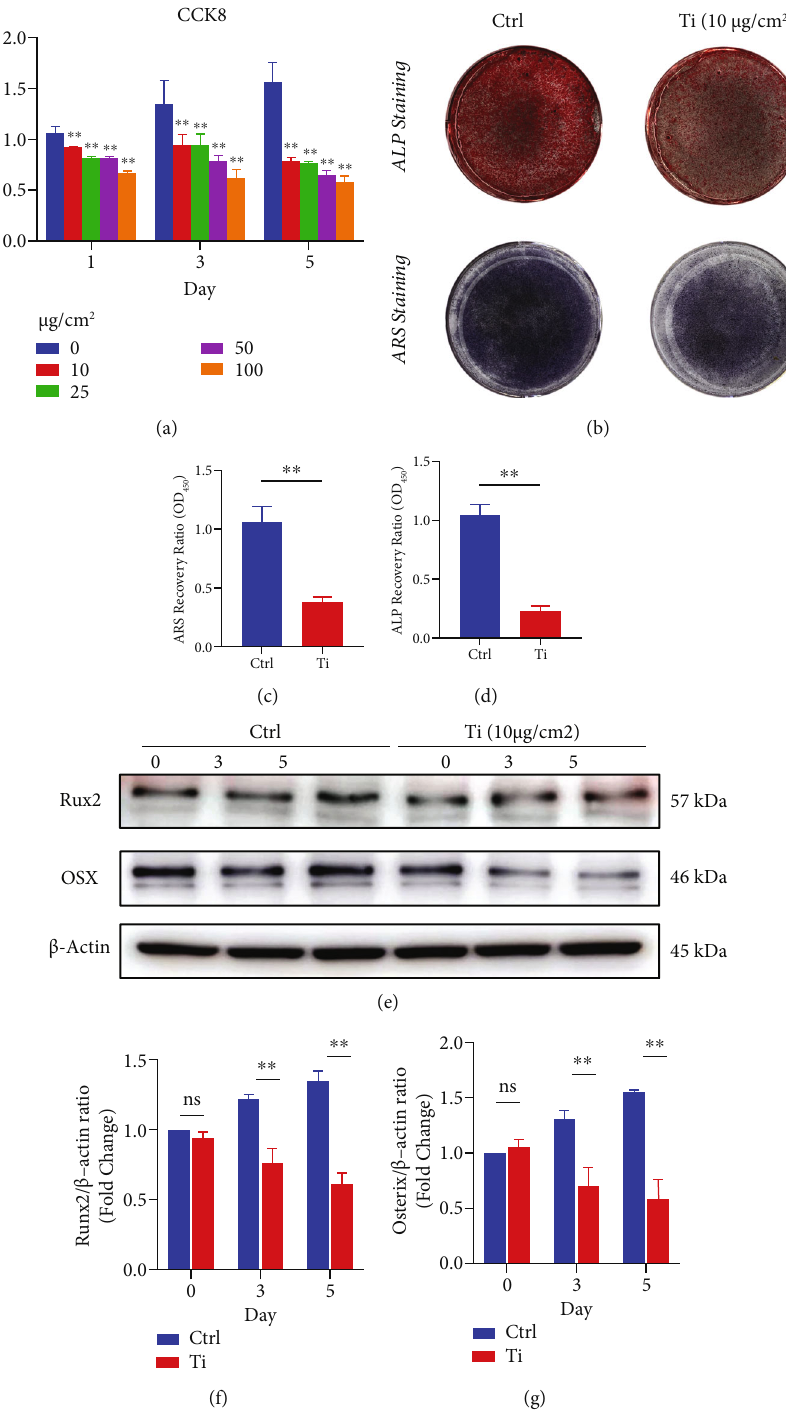
Figure 1: Titanium particles inhibit the di ff erentiation of osteoblasts in vitro . (a) MC3T3-E1 cell viability was measured by the CCK-8 assay. (b) Representative images of ALP and ARS staining in vitro . (c, d) Quanti fi cation of ALP activity and bone mineralization in MC3T3-E1 cells in each group. Note: n = 3 per group; ∗ P < 0 : 05 and ∗∗ P < 0 : 01 compared with the Ctrl group (without titanium particle intervention). (e) Representative images of western blots probed with antibodies against OSX and Runx2. (f, g) Quanti fi cation of OSX and Runx2 protein levels. n = 3 per group. NS: not statistically signi fi cant; ∗ P < 0 : 05 and ∗∗ P < 0 : 01 vs. the ctrl group at the same time